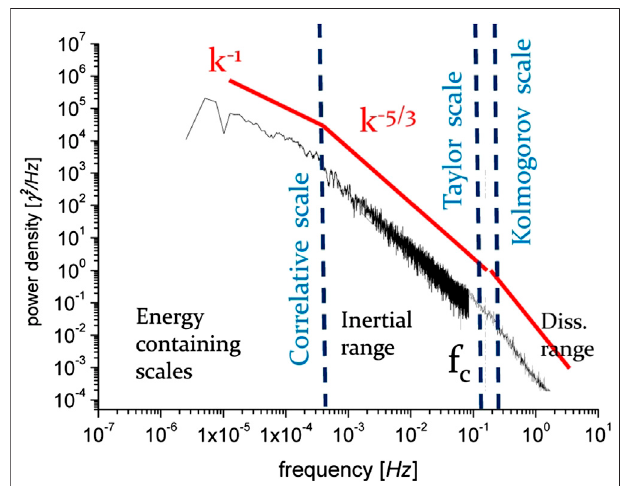
FIGURE 3 | Power spectrum of magnetic fi eld fl uctuations at 1AU. The fi gure is adapted from [18]; copyright by Springer Nature, licensed under CC BY